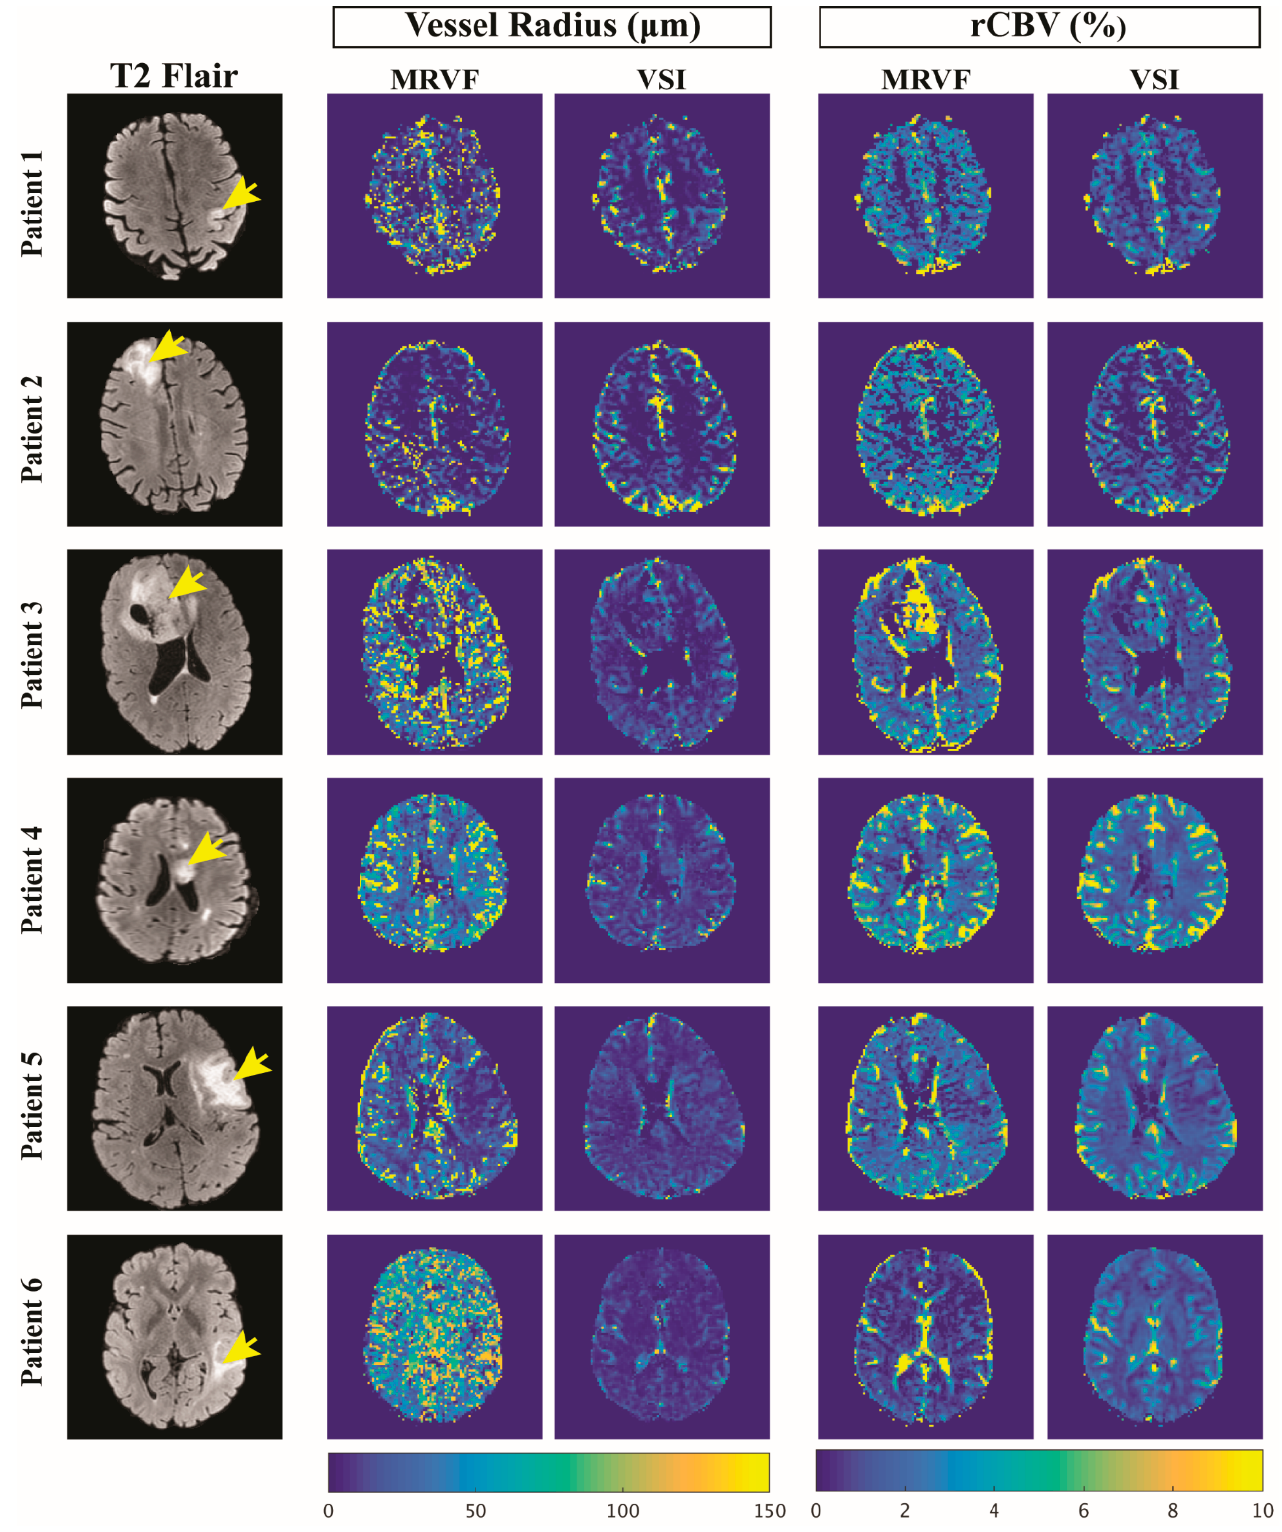
Figure 4. T2 FLAIR images of 6 patient datasets of slices showing the glioma (marked by the yellow arrows) and the corresponding vessel radius (in μ m) and rCBV (in %) maps obtained using the MRVF and the VSI methods. Table 2. Structural Similarity Index Measure (SSIM) between MR vascular fingerprinting (MRVF) and vessel size imaging (VSI) techniques in the estimation of vessel radius and rCBV maps for each